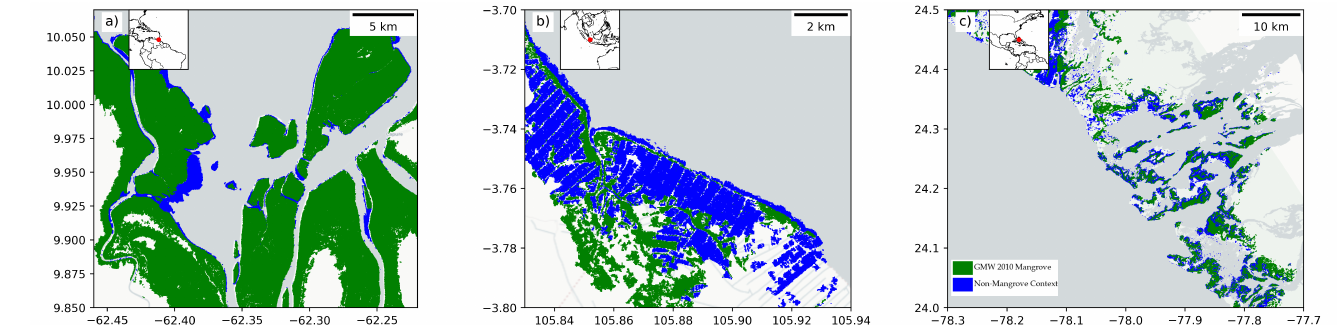
Figure 3. Examples of the contextual regions defining the non-mangrove regions for change ( a ) from Venezuela, where mangroves are expanding, ( b ) from Sumatra, Indonesia, in a region of aquaculture and ( c ) from The Bahamas, where the coastline is complex with many small islands. The green areas are the 2010 v2.5 mangrove baseline, while the blue areas are the contextual areas, indicating there is the potential of mangrove